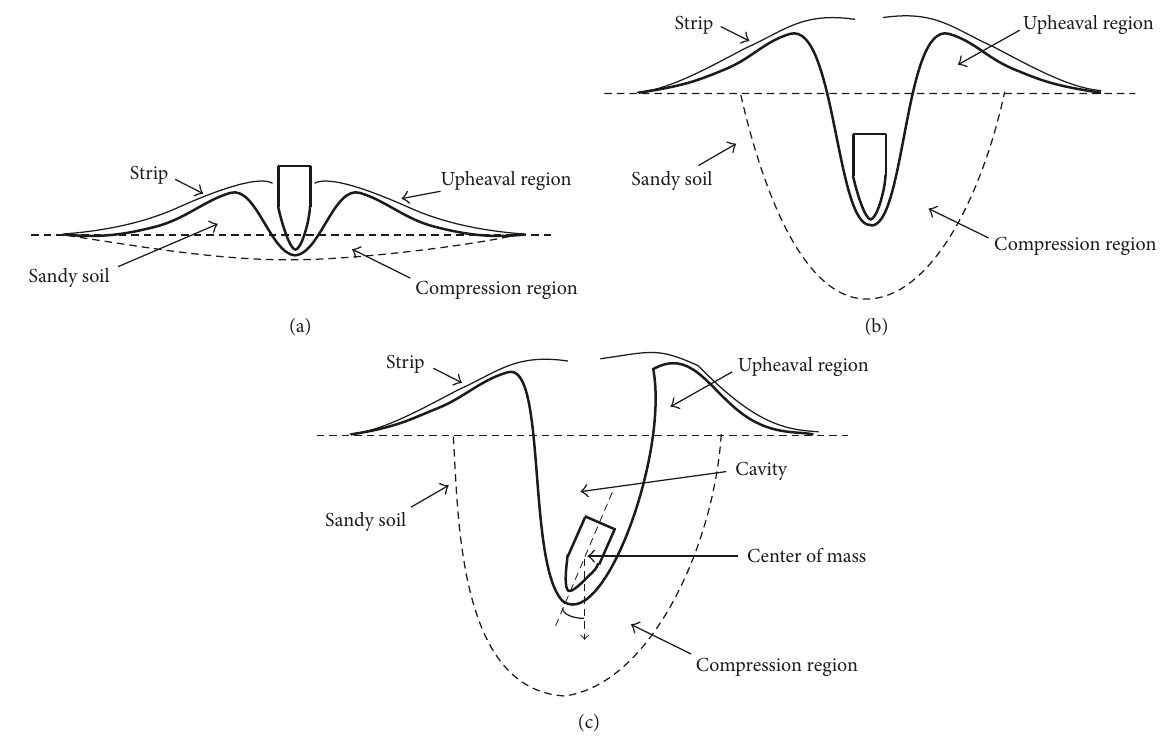
Figure 15. The bell-shape negative acceleration curves were formed as shown in Figure 16. It can be clearly found that the crest of off-axis curve was formed before that of middle-axis curve, which means that the instability occurred easily and early when the POI was set to off-axis position. Meanwhile, the DOP decreased compared with the case of